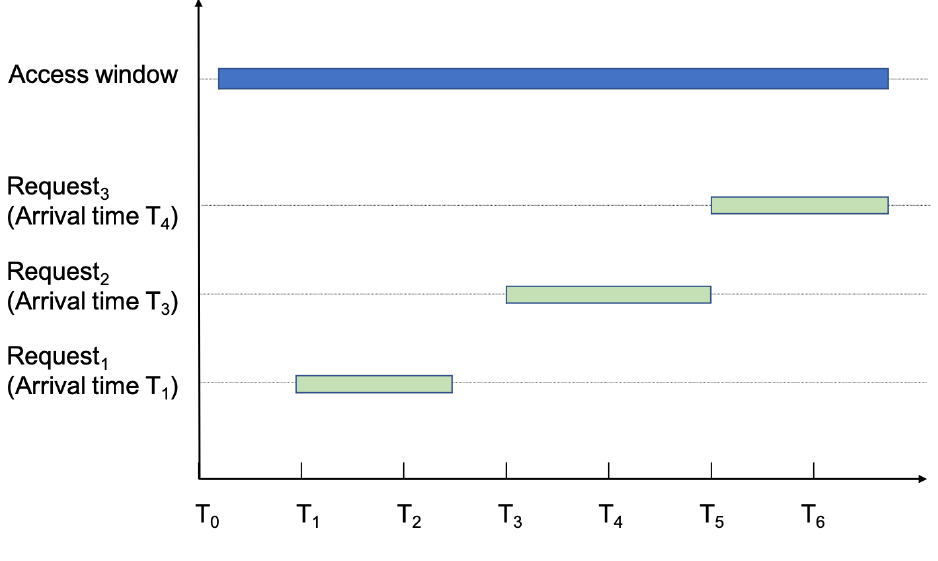
Figure 3. DSA-AT processing